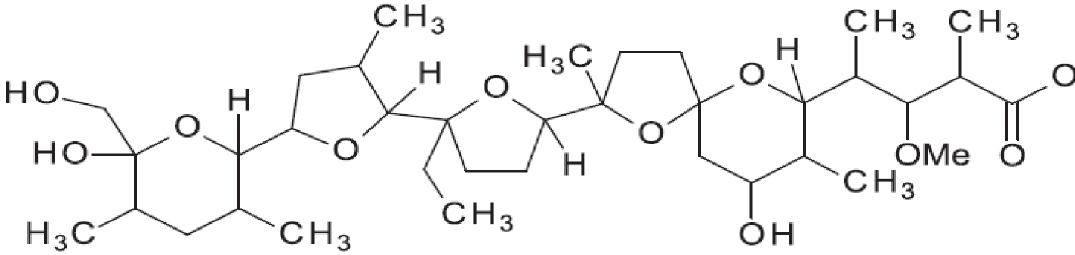
Fig 1. Chemical structure of